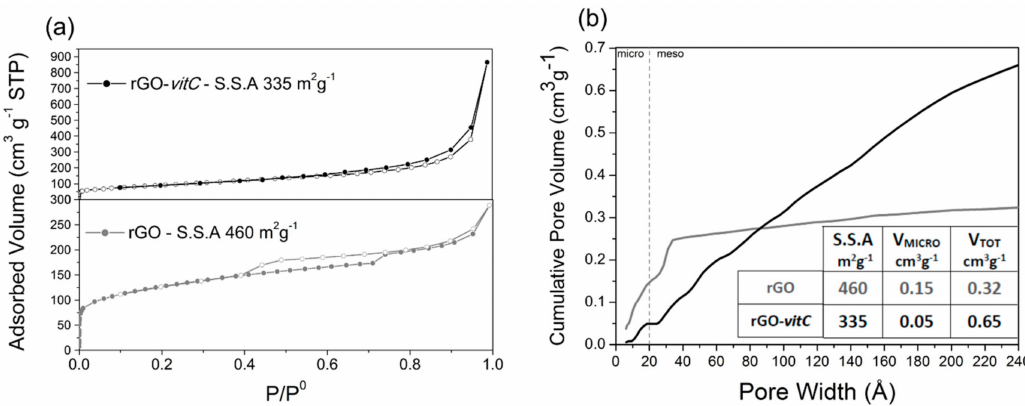
Figure 2. N 2 adsorption / desorption isotherms at 77 K of (lower) rGO and (upper) rGO- vitC- 2 mg / mL ( a ); cumulative pore volume curves of rGO (gray) and rGO- vitC (black) ( b ).